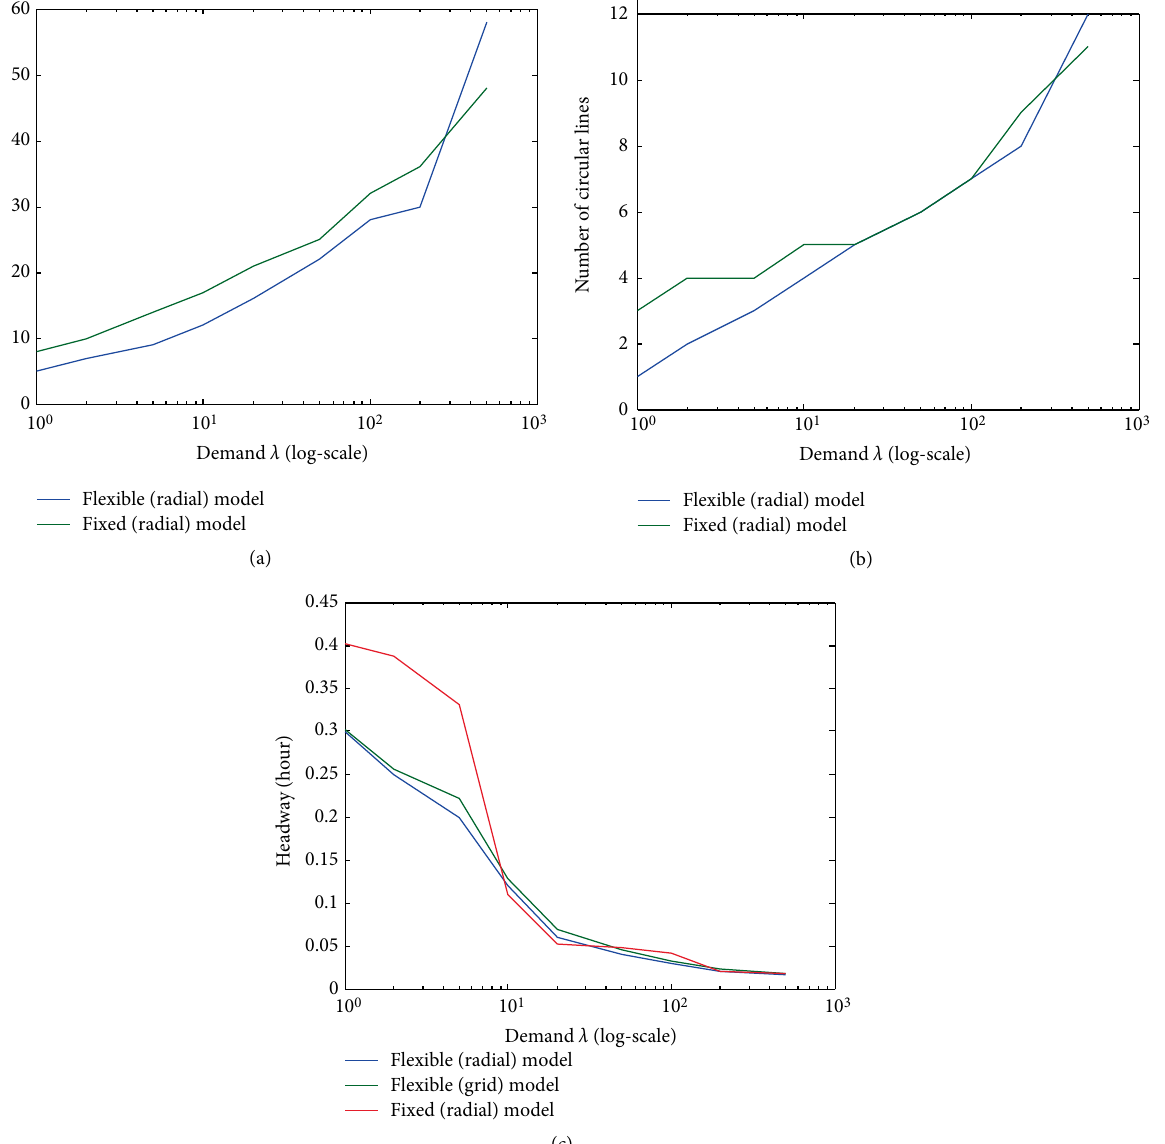
Figure 5: Optimal decision variables of three transit systems. (a) Number of radial lines. (b) Number of circular lines. (c) Headway of three transit